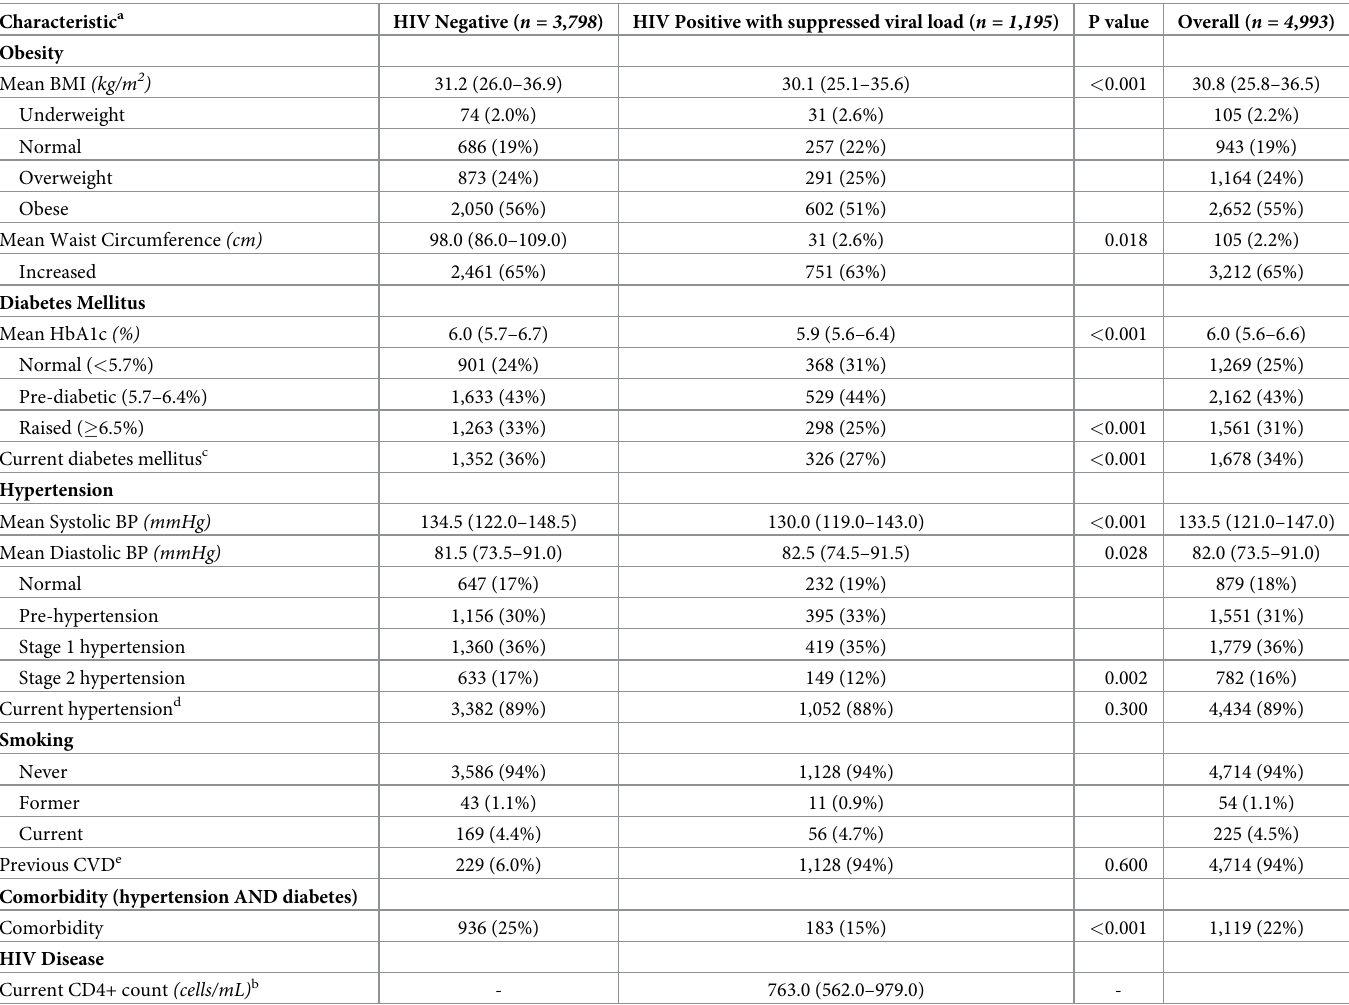
Table 2. Unweighted population prevalence of traditional risk factors among HIV negative versus HIV positive/successful ART adults with hypertension and/or diabetes mellitus in uMkhanyakude, KwaZulu-Natal, South Africa. Characteristic a HIV Negative ( n = 3 , 798